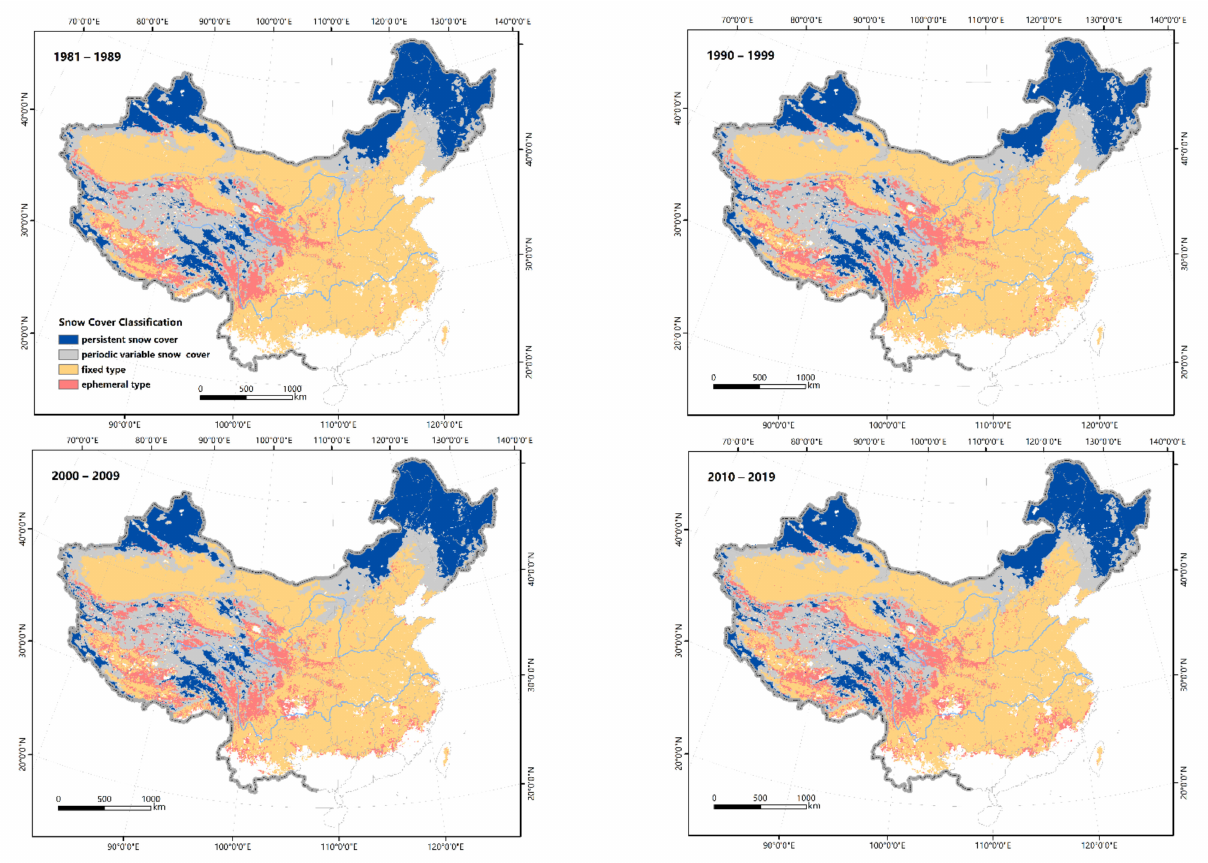
Figure 5. Interdecadal distributions of the recently developed snow cover classification across China from the 1980s to the